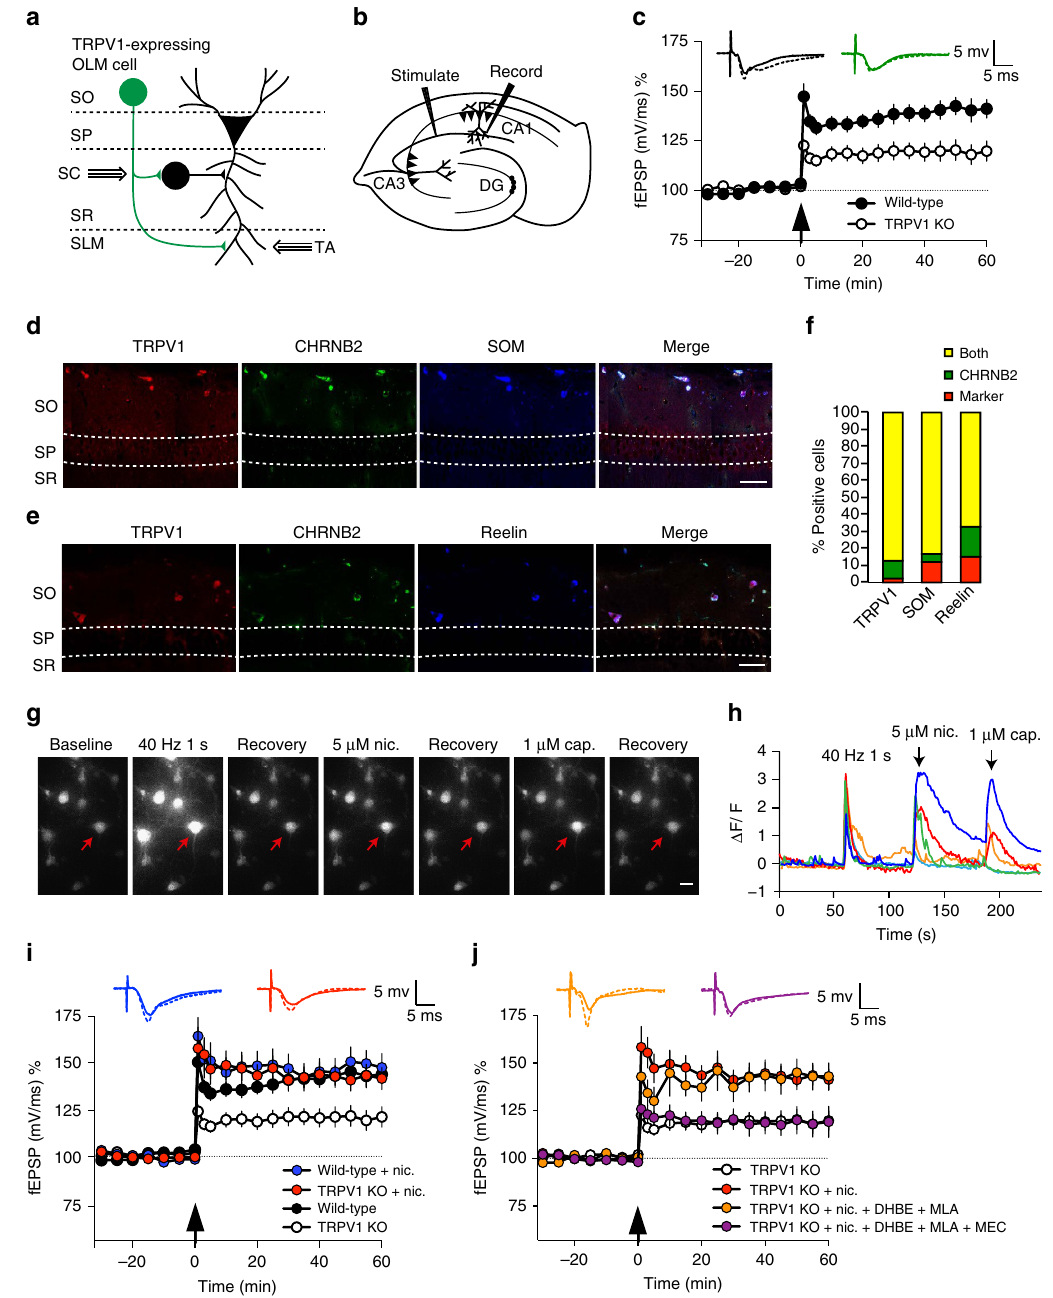
Figure 9 | TRPV1 affects synaptic plasticity in the Schaffer collateral pathway via promoting innervation of OLM cells. ( a ) Scheme of putative connections of a TRPV1-expressing OLM cell in the stratum oriens. OLM cells inhibit the temporoammonic (TA) pathway from the entorhinal cortex, and disinhibit the Schaffer collateral pathway from the CA3 region, thus promoting CA3 input, and reducing EC input, to CA1 pyramidal cells. ( b ) Illustration of stimulating and recording electrode positions for LTP recordings performed in the Schaffer collateral pathway. ( c ) LTP induced by 1XTET-LTP in the